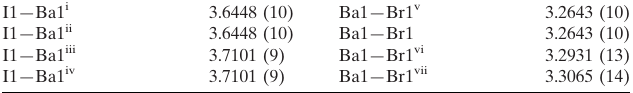
Selected bond lengths (A˚